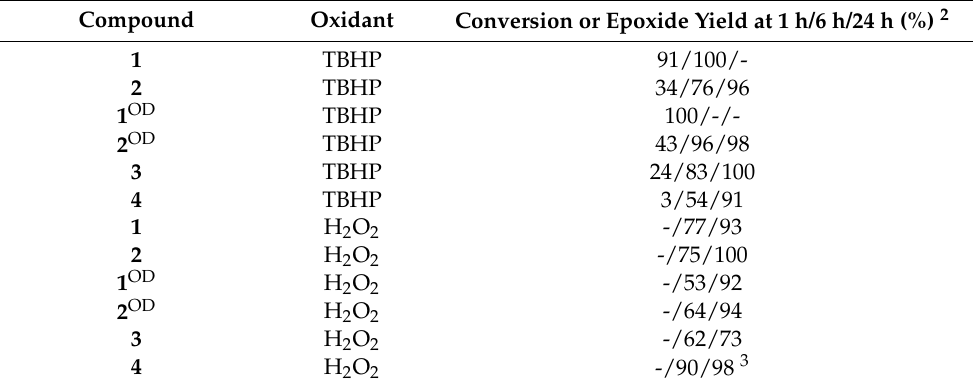
Table 1. Catalytic results for the epoxidation of cis -cyclooctene 1 . Compound